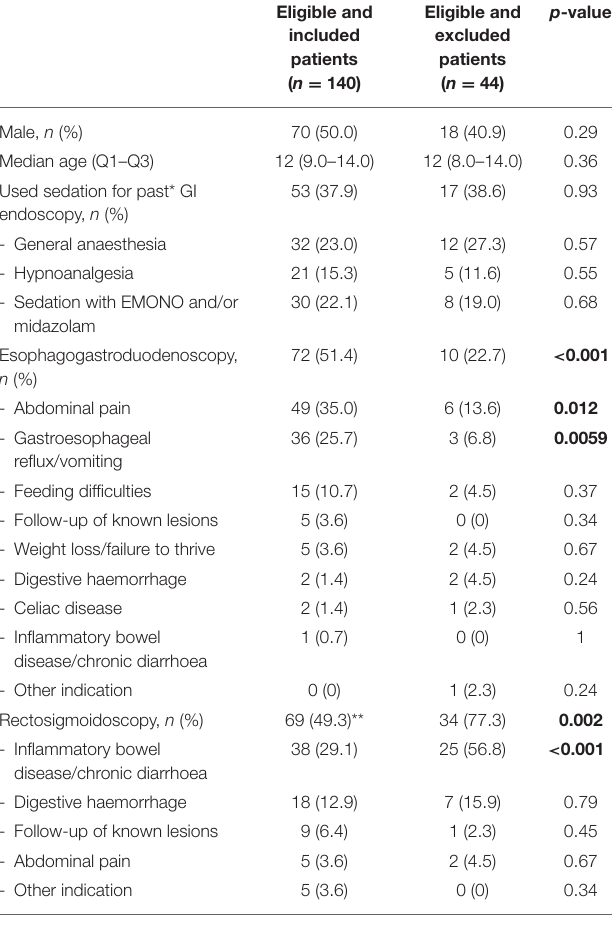
TABLE 1 | Demographic characteristics and indications for gastrointestinal endoscopy in included and excluded patients.